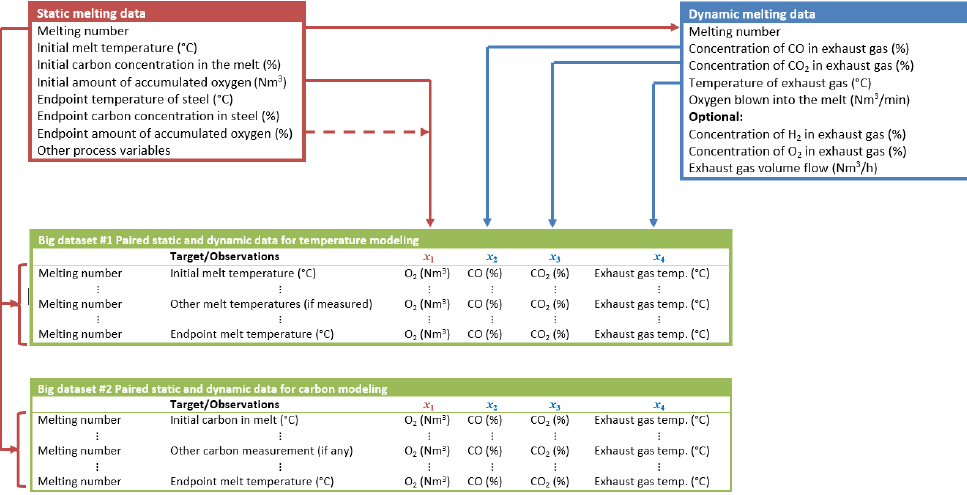
Figure 3. Merging static and dynamic